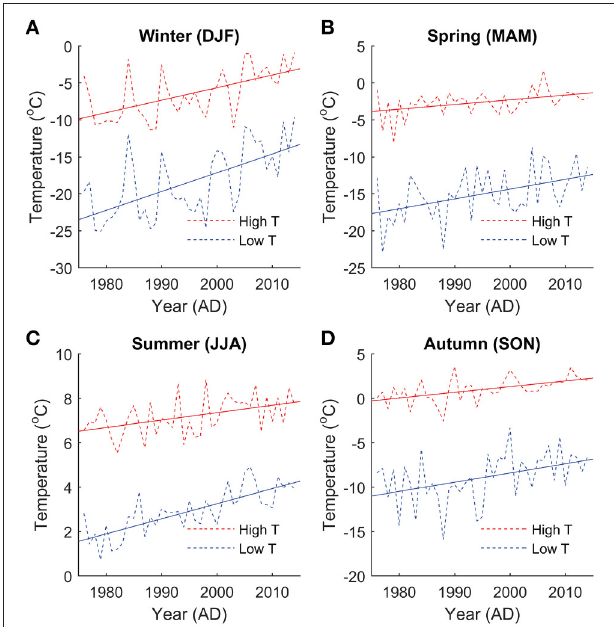
FIGURE 2 | Time-series of winter (DJF; A) , spring (MAM; B ), summer (JJA; C ) and autumn (SON; D ) temperature at Svalbard Airport for the period 1975–2104, averaged per year for above-average (upper 50%; dashed red line) and below-average (lower 50%; dashed blue line)